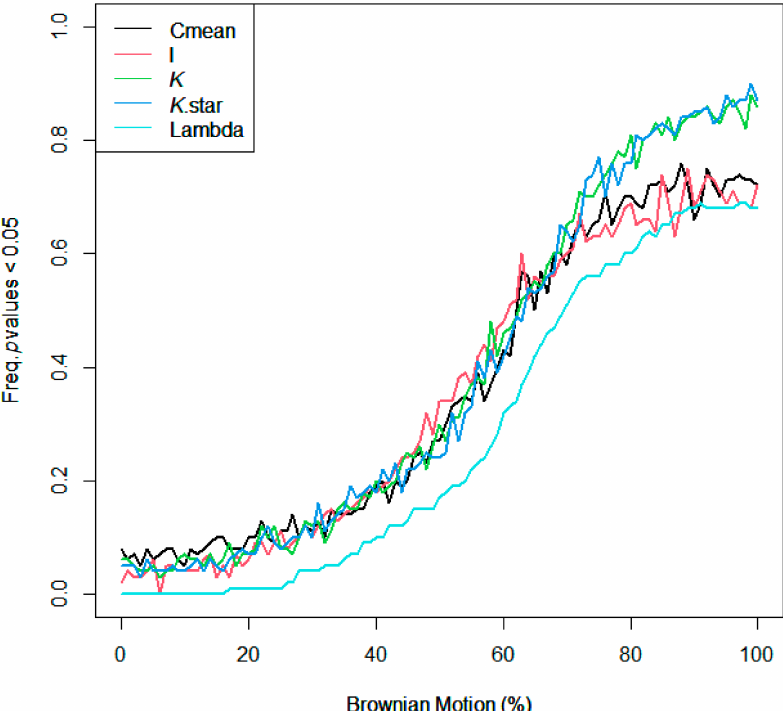
Figure A3. Assessing the behavior of phylogenetic signal via Brownian motion influence gradient.